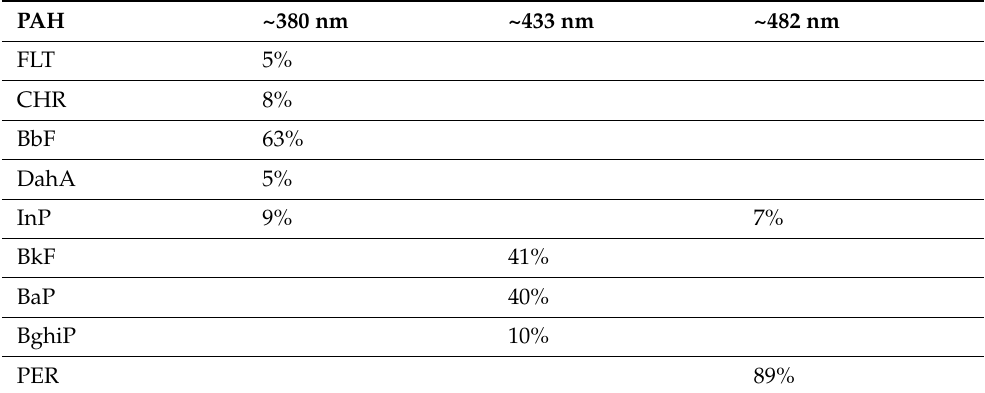
Table 1. Contribution (in %) of PAH molecules to the absorption intensity at different wavelengths (in nm) over Porto. Only molecules with contributions higher or equal than 5% are presented. PAH ~380 nm ~433 nm ~482 nm FLT 5% CHR 8% BbF 63% DahA 5% InP 9% 7% BkF 41% BaP 40% BghiP